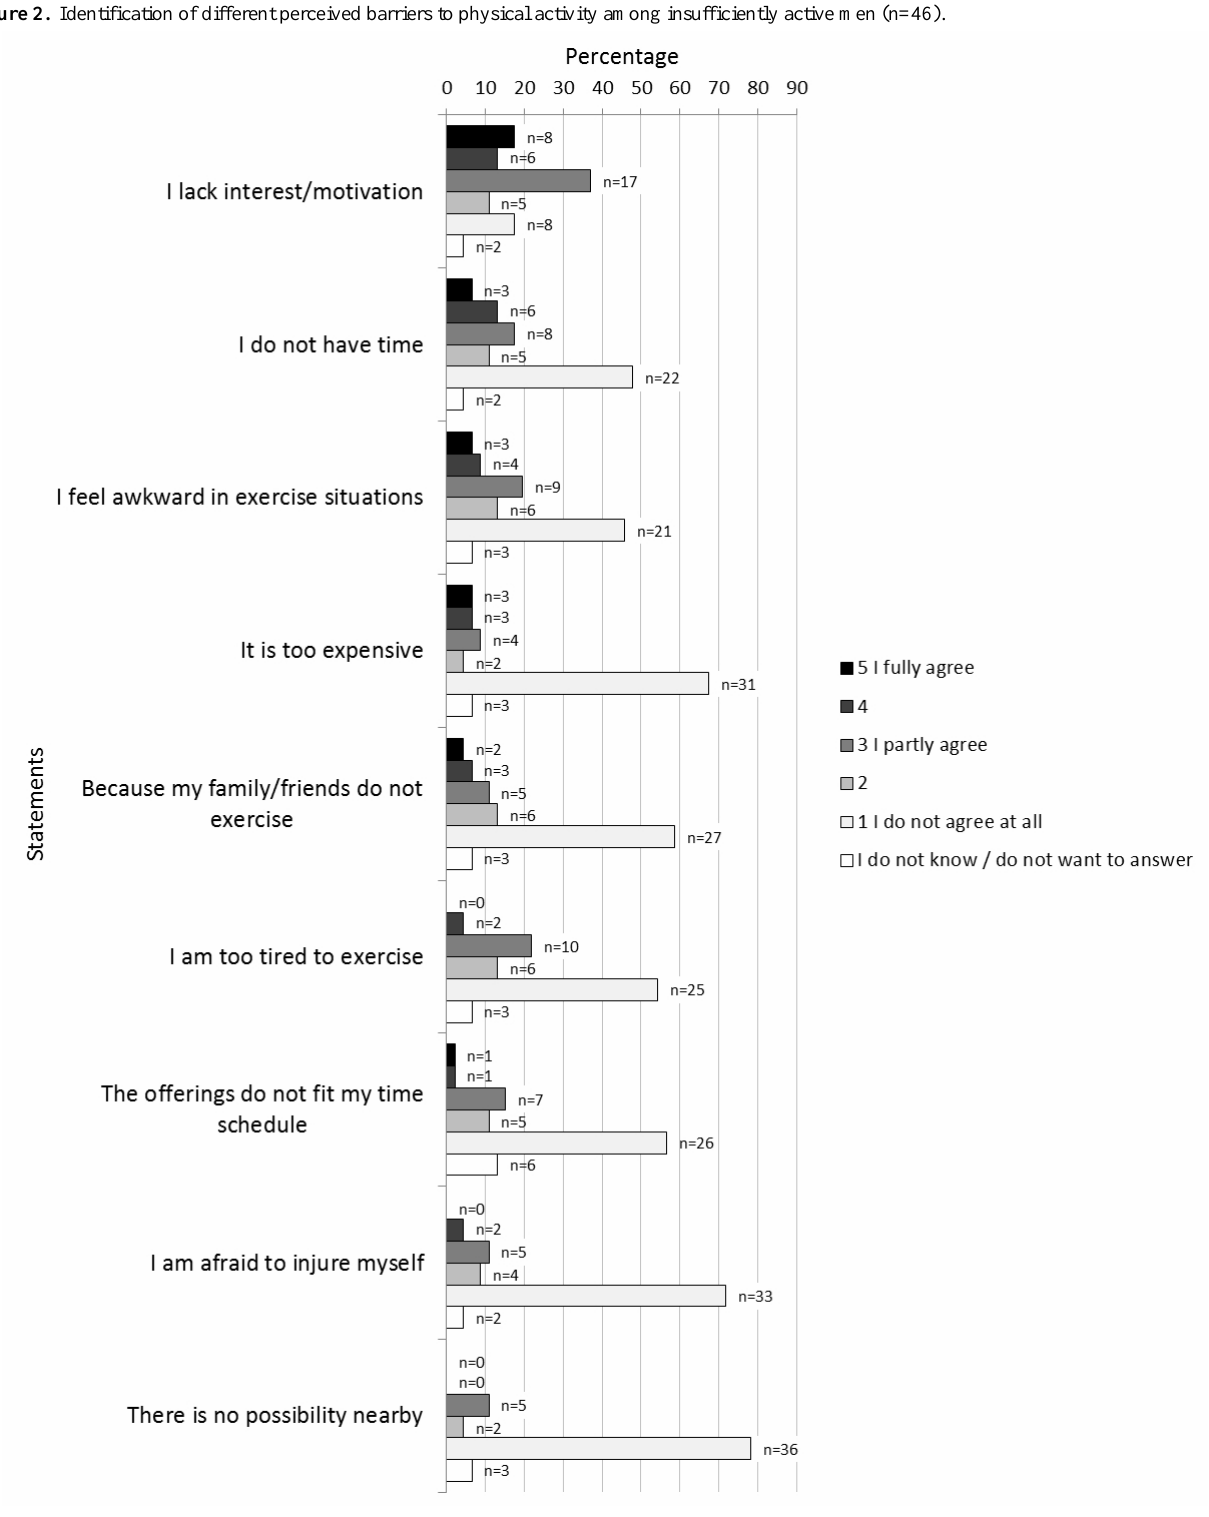
Figure 2. Identification of different perceived barriers to physical activity among insufficiently active men